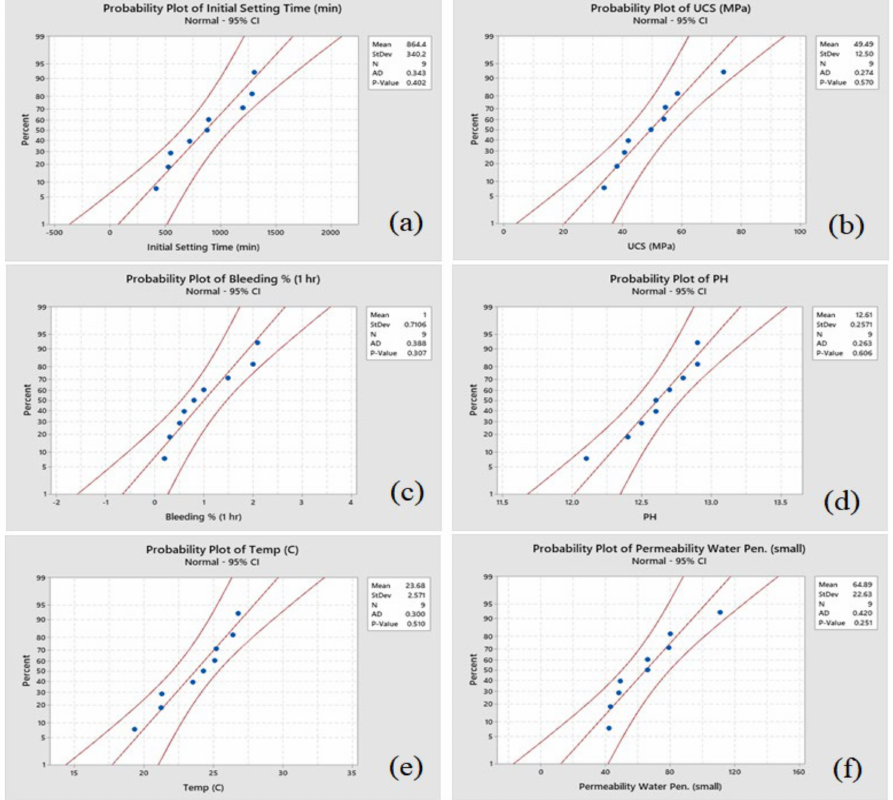
Figure 15. Normal probability plot response for ( a ) initial setting time, ( b ) UCS of cubes (MPa), ( c ) bleeding %, ( d ) pH, ( e ) temperature ( ◦ C), and ( f ) permeability water penetration for fine aggre- gate